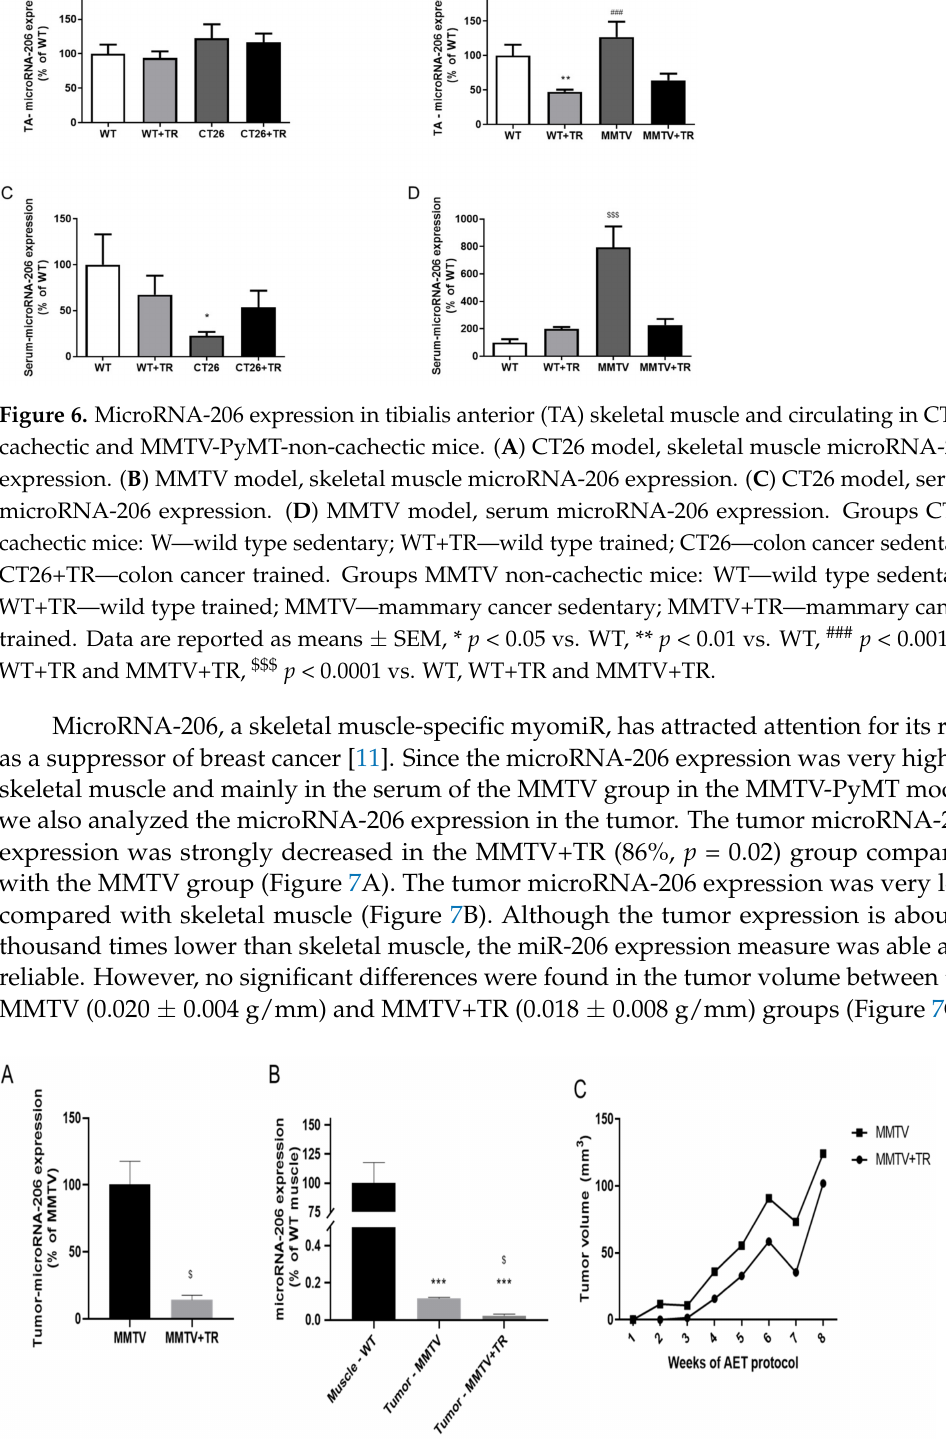
Figure 7. Tumor microRNA-206 expression of MMTV-PyMT model. ( A ) Tumor microRNA-206 expres- sion in MMTV and MMTV+TR groups. ( B ) Comparison of microRNA-206 expression between skeletal muscle and tumors. ( C ) Tumor volume (mm 3 ) in MMTV and MMTV+TR groups. Groups MMTV non-cachectic mice: WT—wild type sedentary; WT+TR—wild type trained; MMTV—mammary cancer sedentary and MMTV+TR mammary cancer trained. Data are reported as means ± SEM. *** p < 0.05 vs. WT, $ p < 0.05 vs.